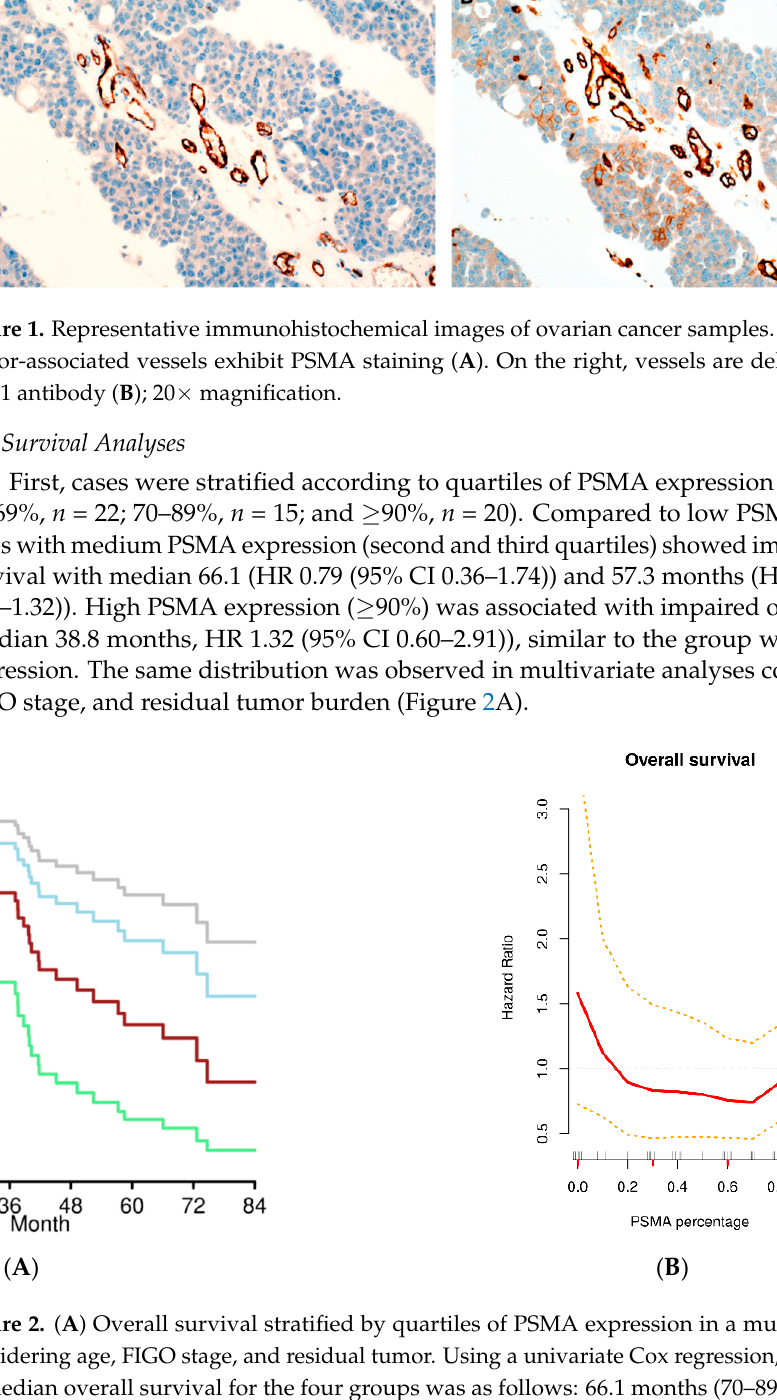
Figure 1. Representative immunohistochemical images of ovarian cancer samples. On the left, 90% tumor-associated vessels exhibit PSMA staining ( A ). On the right, vessels are delineated using a CD31 antibody ( B ); 20× magnification.